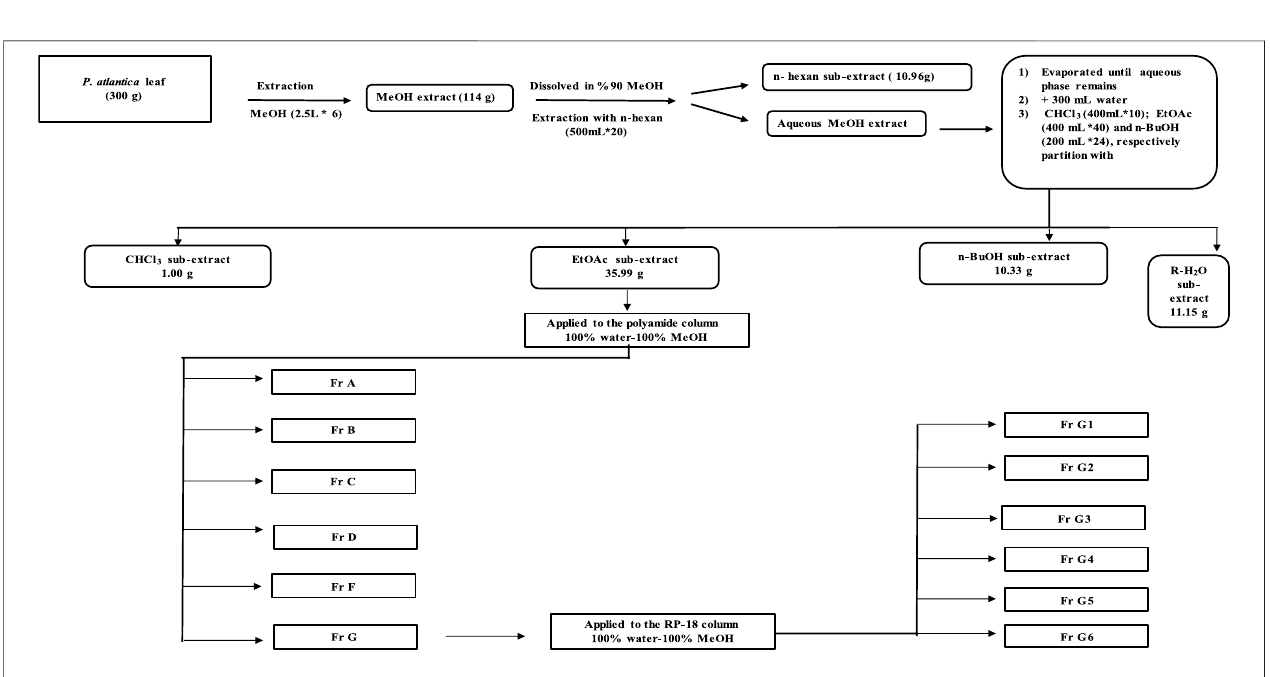
FIGURE 5 | Activity-guided fractionation fl ow chart.